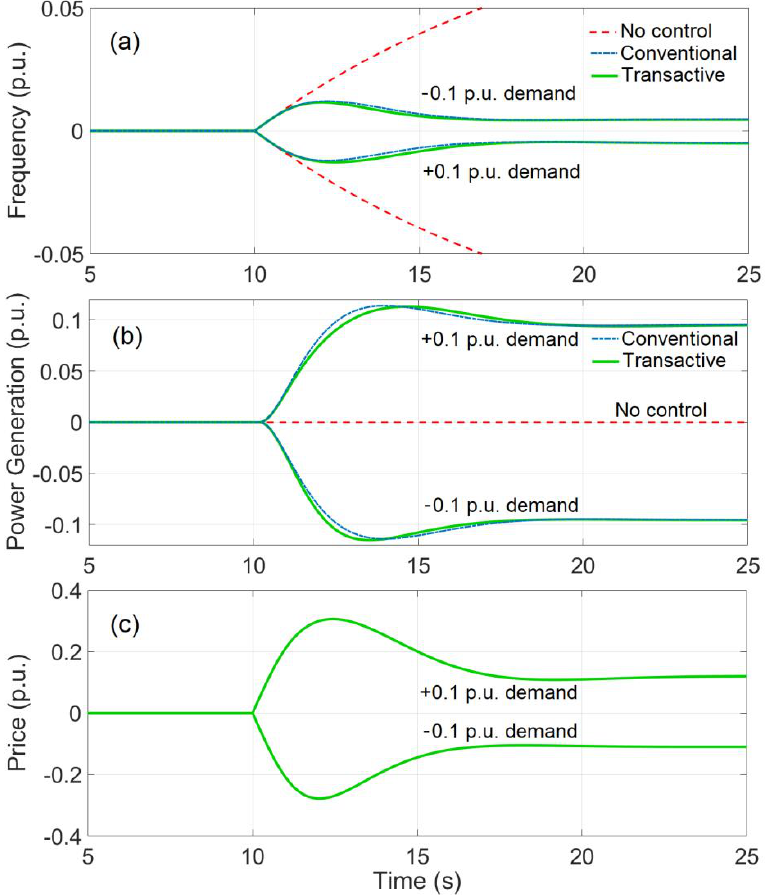
Figure 6. Responses of the conventional and transactive frequency droop controllers to ±10% step change in demand: ( a ) Frequency, ( b ) power generation, and ( c ) transactive controller’s price response.